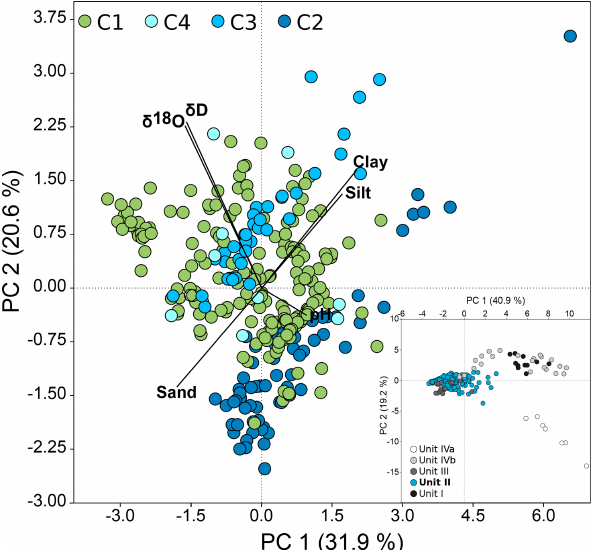
Figure 3. PCA of environmental, sedimentological, and pore water data from Unit II of all four cores, with PC 1 explaining 31.9% and PC 2 explaining 20.6% of the variance between samples. Vectors show selected physicochemical factors that are mainly responsible for the variance between samples (see loadings plot in Fig. S4). C1: n = 183, C2: n = 66, C3: n = 38, C4: n = 9. Outliers located out- side the 95% ellipses were removed. The insert presents all samples of the onshore–offshore transect coloured irrespective of the cores by unit ( n =